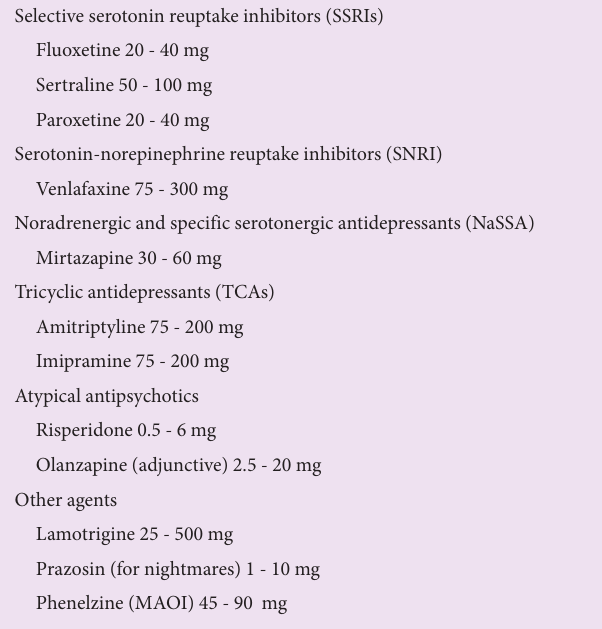
Table 1. Recommended daily drug doses for post-traumatic stress disorder [15] * Selective serotonin reuptake inhibitors (SSRIs) Fluoxetine 20 - 40